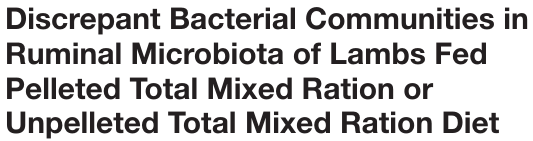
TABLE 2 | Effects of dietary types on rumen fermentable parameters of fattening